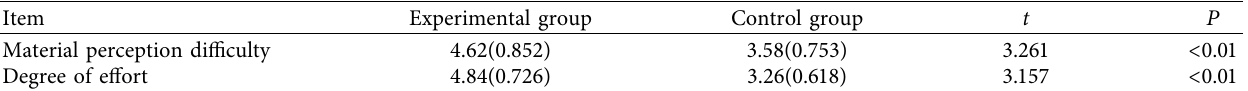
Table 2: Comparison of cognitive load between the two groups.